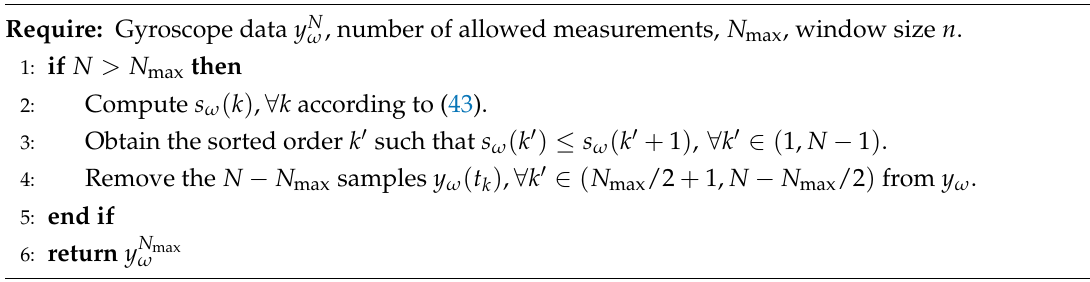
Algorithm 2 Gyroscope sample